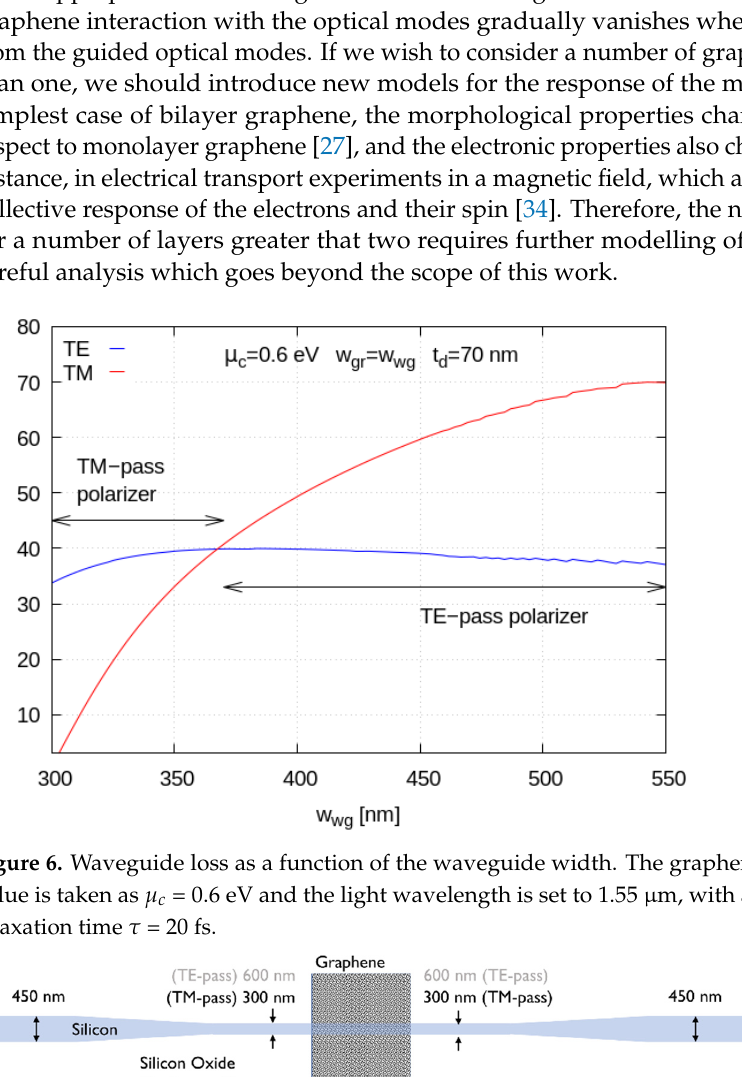
Figure 5. TE ( left panel ) and TM ( right panel ) modes of the SOI waveguides coupled to graphene nanoribbons ( µ c = 1.6 eV).